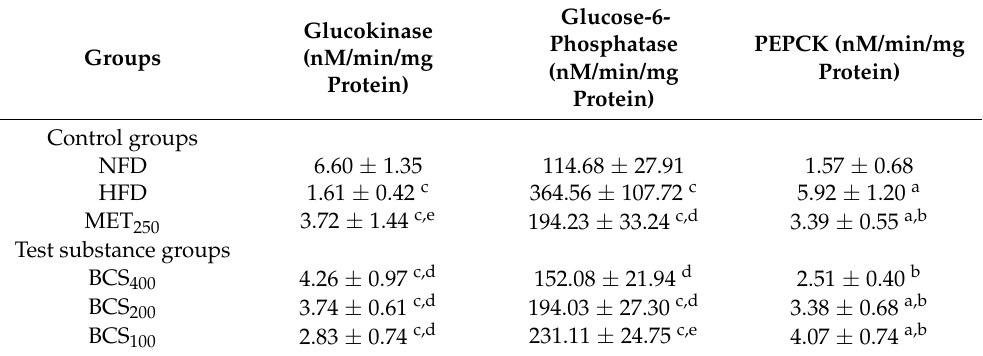
Table 9. Activities of hepatic glucose-regulating enzymes in the HFD- and NFD-supplied groups.